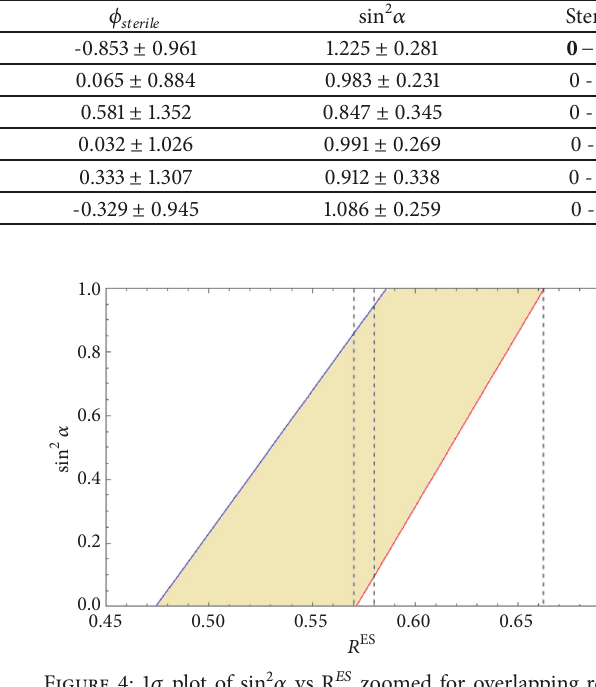
Figure 3: 1 𝜎 plot of sin 2 𝛼 vs R 𝐸𝑆 for KamLAND (dotted lines), Borexino Phase-I (red lines), and Borexino Phase-II (blue lines). The shaded region corresponds to the overlapping region of all three experiments.